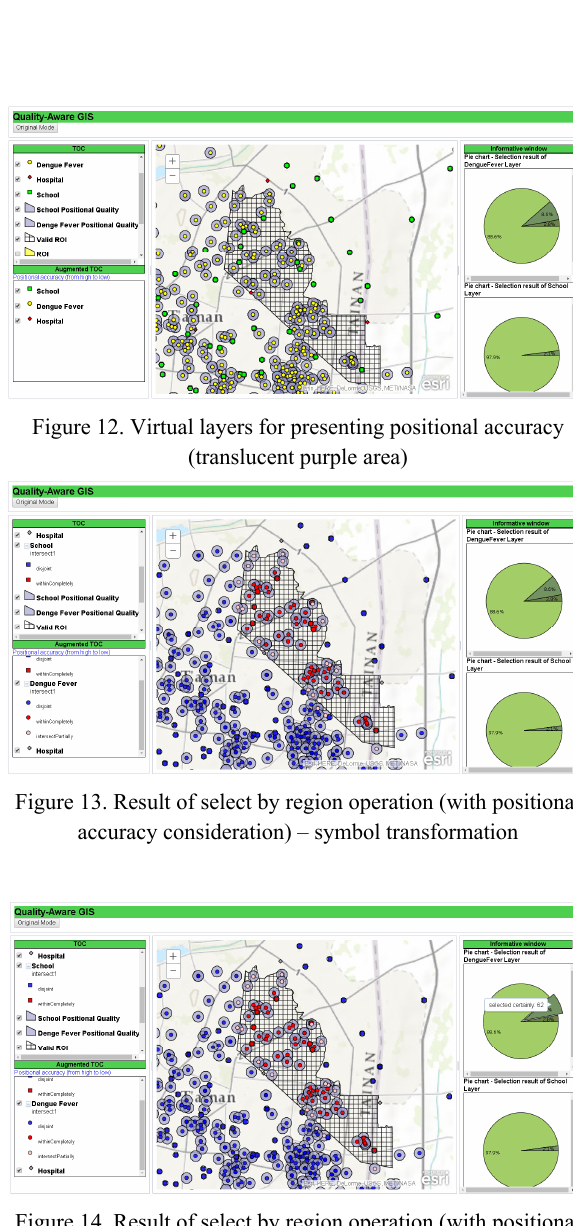
Figure 14. Result of select by region operation (with positional accuracy consideration) – informative window (pie chart)